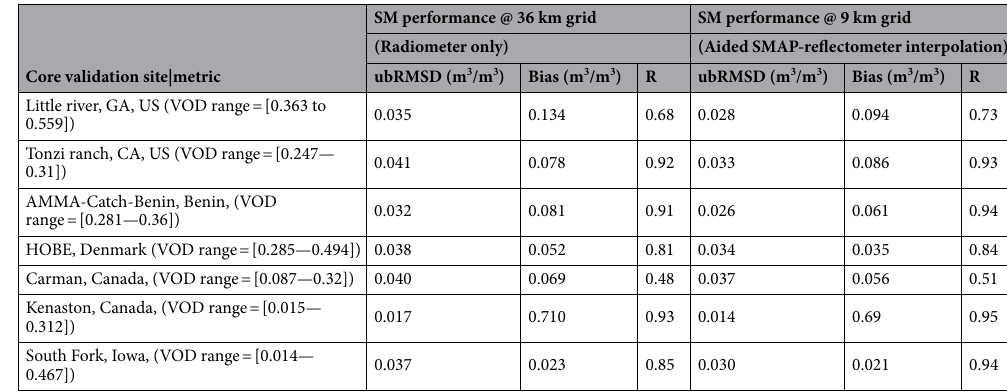
Table 1. Yearly mean ubRMSD, bias, and Pearson correlation coefficient I for the soil moisture (SM) estimates compared to in-situ measurements at different CVS. Comparison is evaluated for the two different SM products obtained from ingesting radiometer only data and radiometer data interpolated with SMAP- Reflectometer at 9 km into the SM-ANN model.